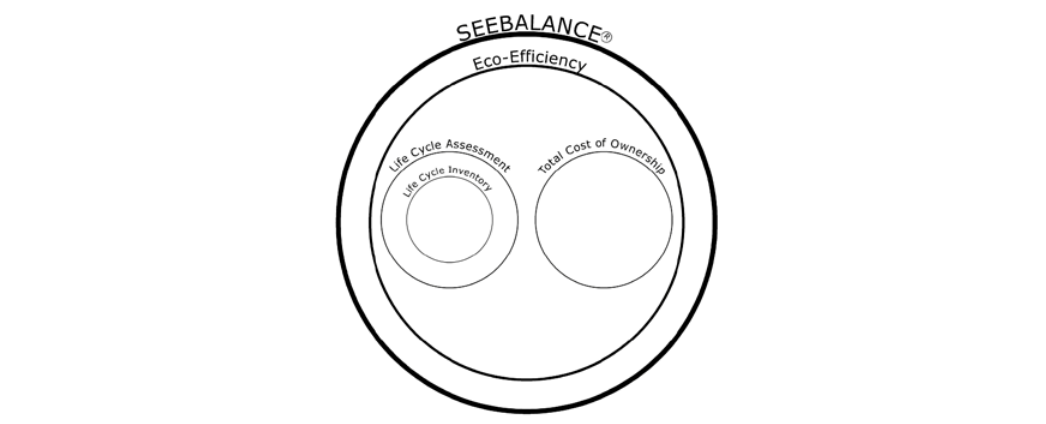
Figure 3. “Difference between Eco Efficiency Analysis and Life Cycle Analysis”. Source: BASF et al.